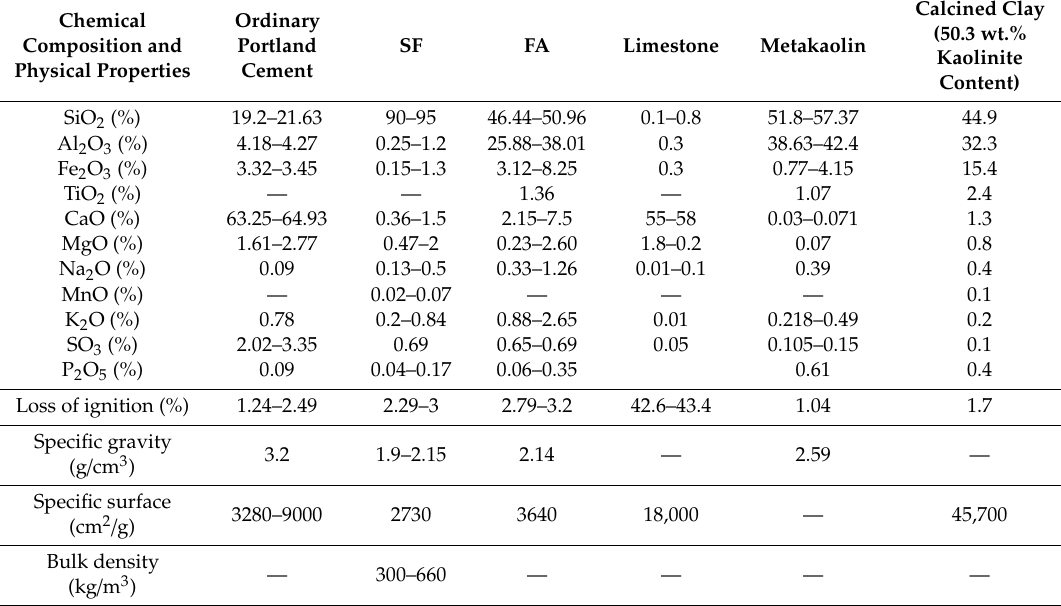
Table 1. Typical composition and properties of ordinary Portland cement (OPC), SF, FA, limestone, metakaolin and calcined clay